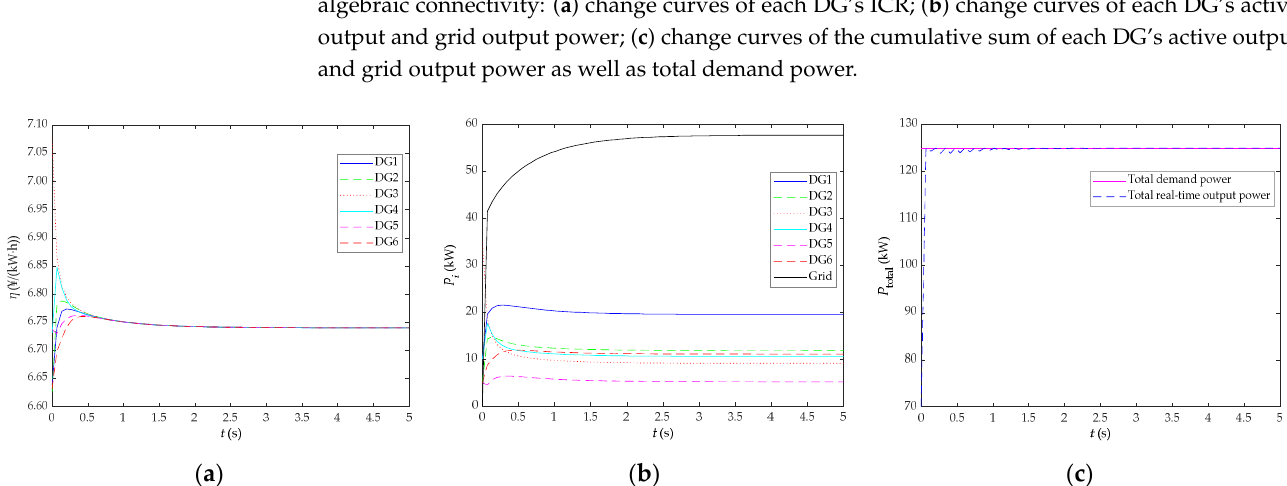
Figure 22. Change curves of variables of the system under the communication topology of high algebraic connectivity: ( a ) change curves of each DG’s ICR; ( b ) change curves of each DG’s active output and grid output power; ( c ) change curves of the cumulative sum of each DG’s active output and grid output power as well as total demand power.